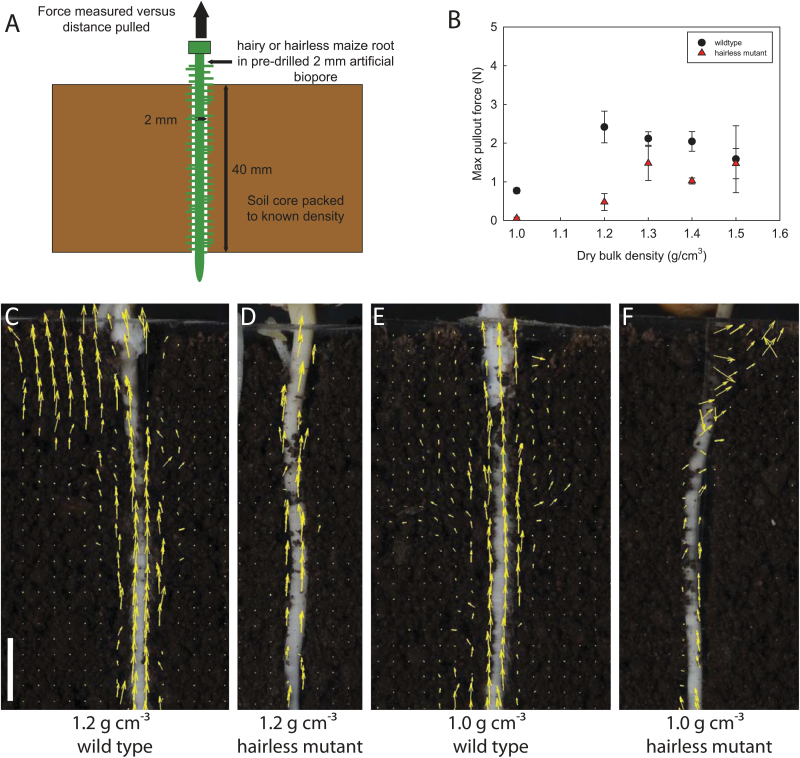
(A) Schematic diagram showing a maize root grown through an artificial cylindrical biopore in a soil core, prior to root pull-out. (B) Plot of maximum pull-out force as a function of soil dry bulk density. (C, D, E, F) Vector displacement fields measured from images during pull-out of roots grown in cylindrical biopores adjacent to a transparent plastic interface. The scale for panels C–F is the same and is indicated by a white bar in (C), representing 5mm. In all figures the yellow vectors are spaced on a regular grid and represent displacement, with the longest vector representing a displacement of 0.1mm (i.e. vectors are magnified relative to the scale of the underlying image). (C, E) Wild-type seedlings; (D, F) hairless mutants. (C, D) Soil dry bulk density 1.2g cm−3;(E, F) soil bulk density 1.0g cm−3.